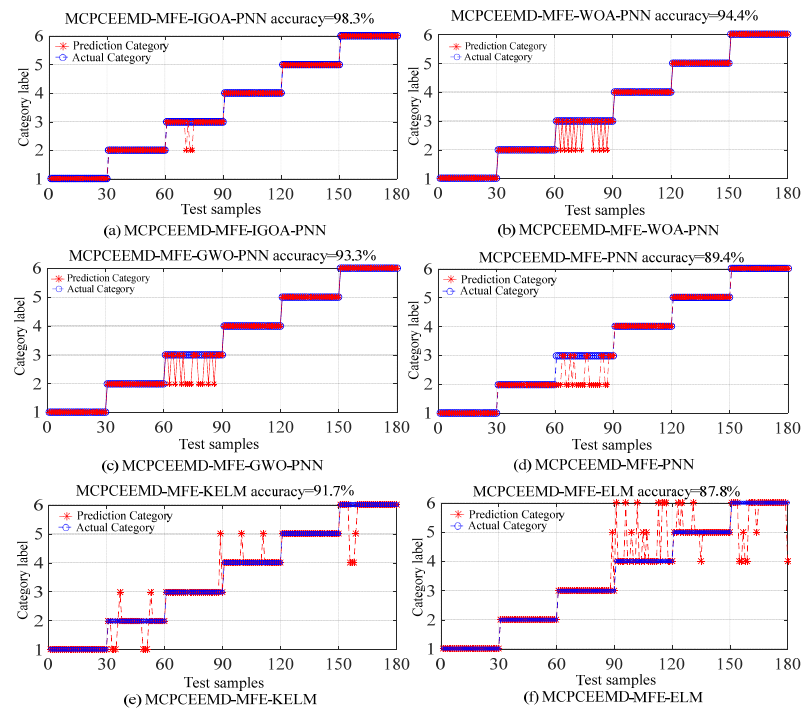
Figure 14. HVSR fault identification results for different models.